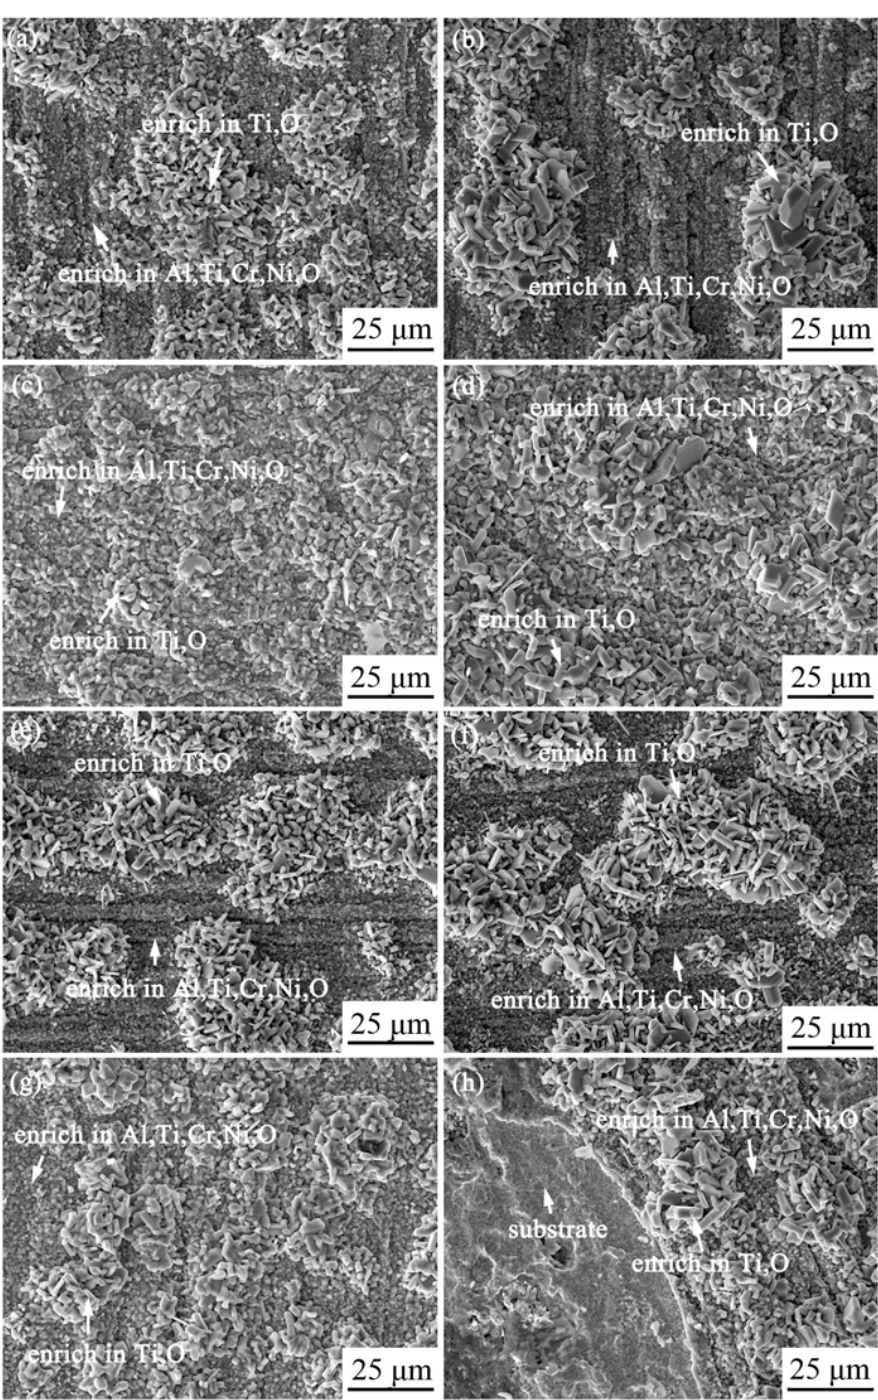
. Figure 8. Morphologies and EDS analyses of the oxide scales formed on E7, E71, E73 and E75 alloys after isothermal oxidation at 1000 ◦ C. ( a , c , e , g ): E7, E71, E73 and E75 for 100 h, respectively. ( b , d , f , h ): E7, E71, E73 and E75 for 500 h, respectively. Cross-section morphologies of the oxide scales formed on E7, E71, E73 and E75 alloys after oxidation at 1000 °C for 100 h are illustrated in Figures 9 and 10. There are two types of regions in the cross-section: the raised surface region and the plain surface region, in correspondence with the two regions in Figure 8. For the E7 alloy oxidized for 100 h, the plain surface region consisted of three layers. The outer layer was a compact oxide layer enriched in Cr, Al and Ni. A small amount of white Ta-enriched oxides appeared in this layer. The inner layer was a continuous Al 2 O 3 layer. In addition, small amounts of TiN particles were formed in the front of the oxidation layer (Figure 10a and Table 3). The